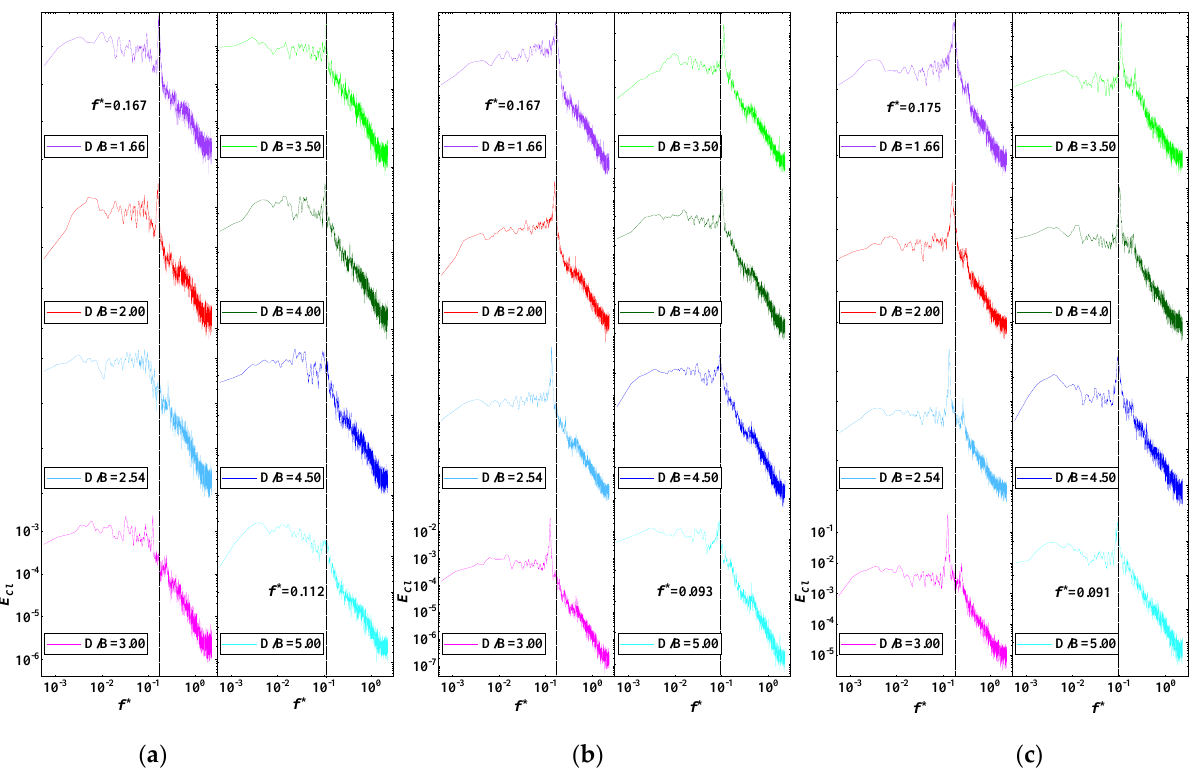
( d ) Figure 20. Wind pressure coefficient of the downstream bridge for Case 3: ( a ) Mean values of the outer taps; ( b ) RMS values of the outer taps; ( c ) Mean values of the inner taps; ( d ) RMS values of the inner taps. The PSD value of the lift coefficients for Case 3 is plotted in Figure 21. An obvious peak frequency point was clearly identified in the PSD distributions of the vehicle and upstream and downstream bridges for various D/B ratios. However, the frequency point decreased as the D/B increased. There was a line to divide the vortex shedding frequency into lower and higher frequencies when D/B = 3.00. When D/B was no more than 3.00, the vortex shedding frequencies of the vehicle and upstream and downstream bridges were